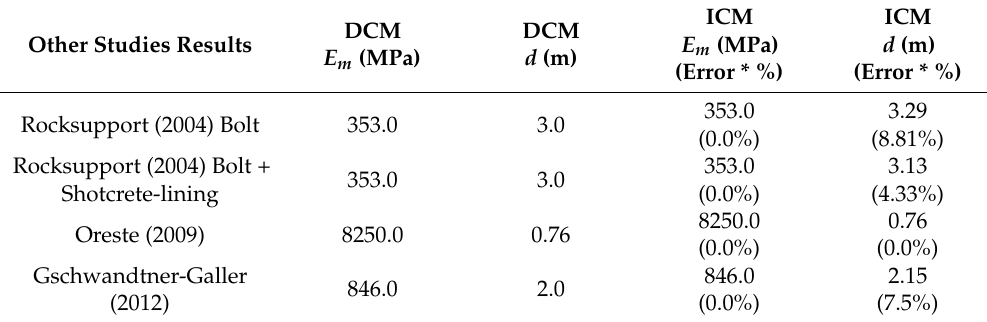
Table 6. Output data and comparison of results between ICM and other studies [19,20,26].